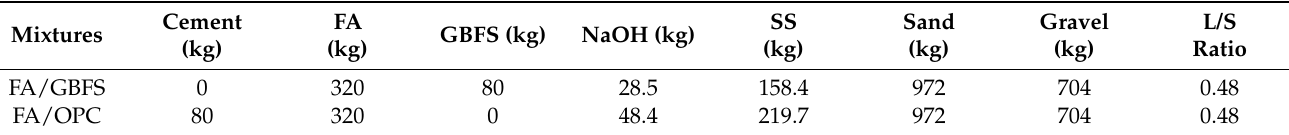
Table 2. Concrete design (kg/m 3 ) and liquid/solid ratio.